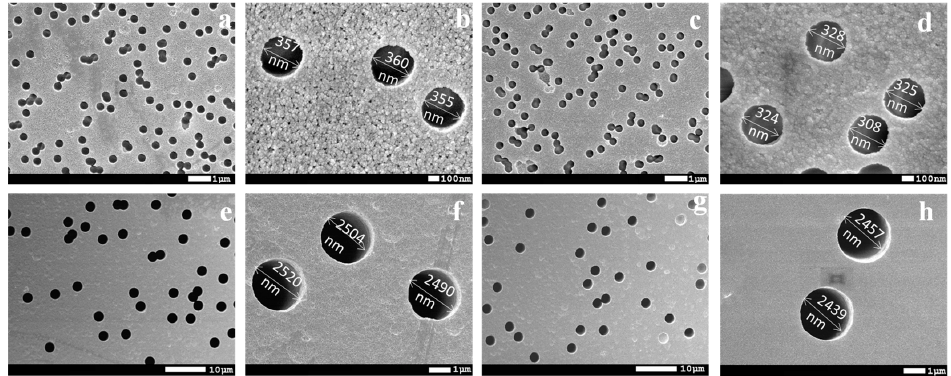
Figure 4. AFM images of original PET TeMs (1 × 10 8 ) ( a ), in comparison with SM-grafted PET TeMs at grafting degree of 3.6% ( b ) and 15.1% ( c ) with size of 10 × 10 µm. At optimal conditions, PET TeMs with a pore density of 1 × 10 8 , a pore size of 350 nm